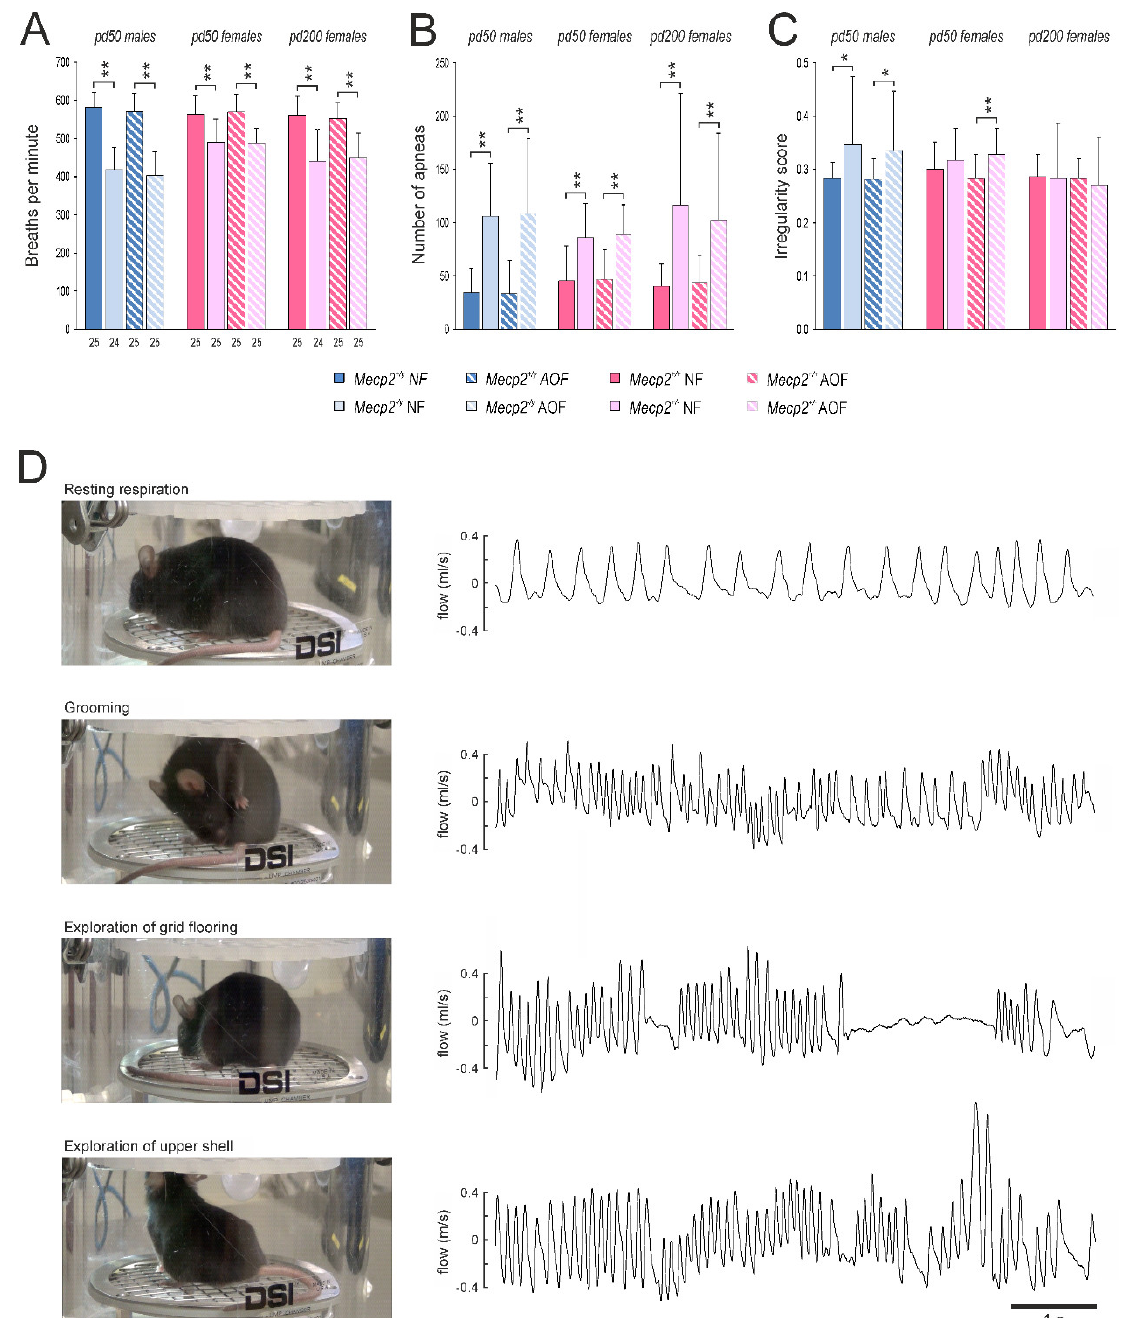
Figure 4. The distorted breathing of Mecp2 -mutant mice was not rescued by AO treatment. ( A ) Both Mecp2 −/ y and Mecp2 +/− mice showed markedly higher breathing frequencies than the respective WTs. ( B ) Breathing arrests (apneas exceeding 250 ms duration; counted over 3 min) were far more frequent in male and female Mecp2 -mutant mice. ( C ) Moreover, the regularity of breathing was/tended to be more distorted in Mecp2 −/ y and Mecp2 +/− mice on pd 50 than in WT mice. None of these respiratory parameters were affected by the AO cocktail. ( D ) Unrestrained whole-body plethysmography gave rise to a complex breathing behavior, which may markedly differ from resting respiration. Especially, exploratory activity and grooming were associated with more irregular breathing patterns and higher frequencies. Pictures and traces were obtained from an AO-fed WT female on pd 200. The number of mice analyzed is indicated in panel ( A ). Genotype-related significant changes are identified by asterisks (* p < 0.05, ** p < 0.01; two-way ANOVAs followed by Holm–Sidak post-hoc